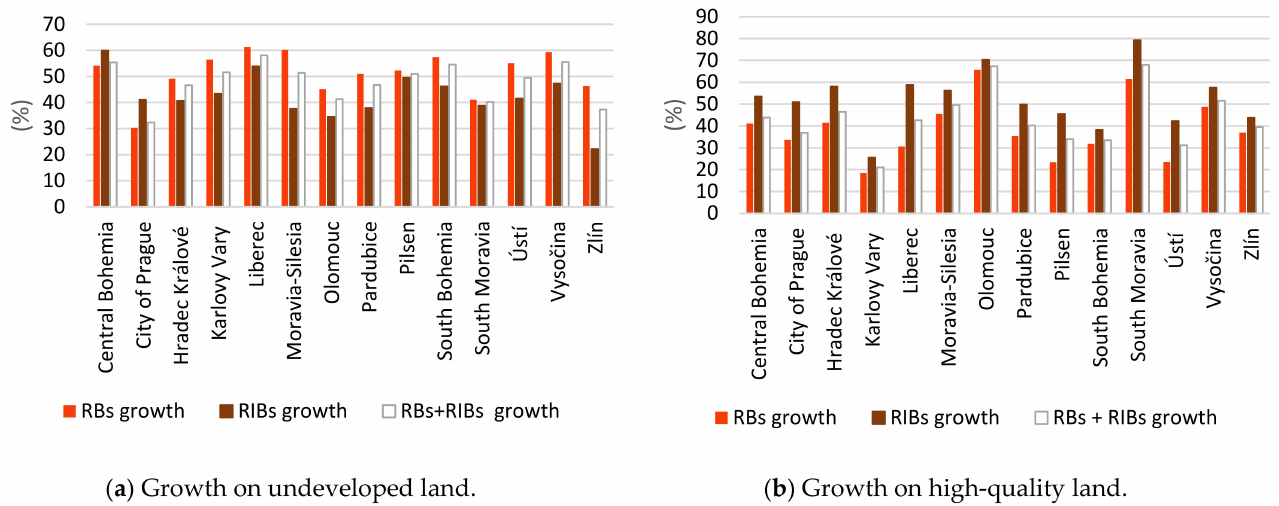
Figure 3. Percentages of buildings (RBs, RIBs, and RBs + RIBs) built on undeveloped land ( a ) and high-quality land ( b ) in the Czech Republic between 2006 and 2016. 100% = buildings built